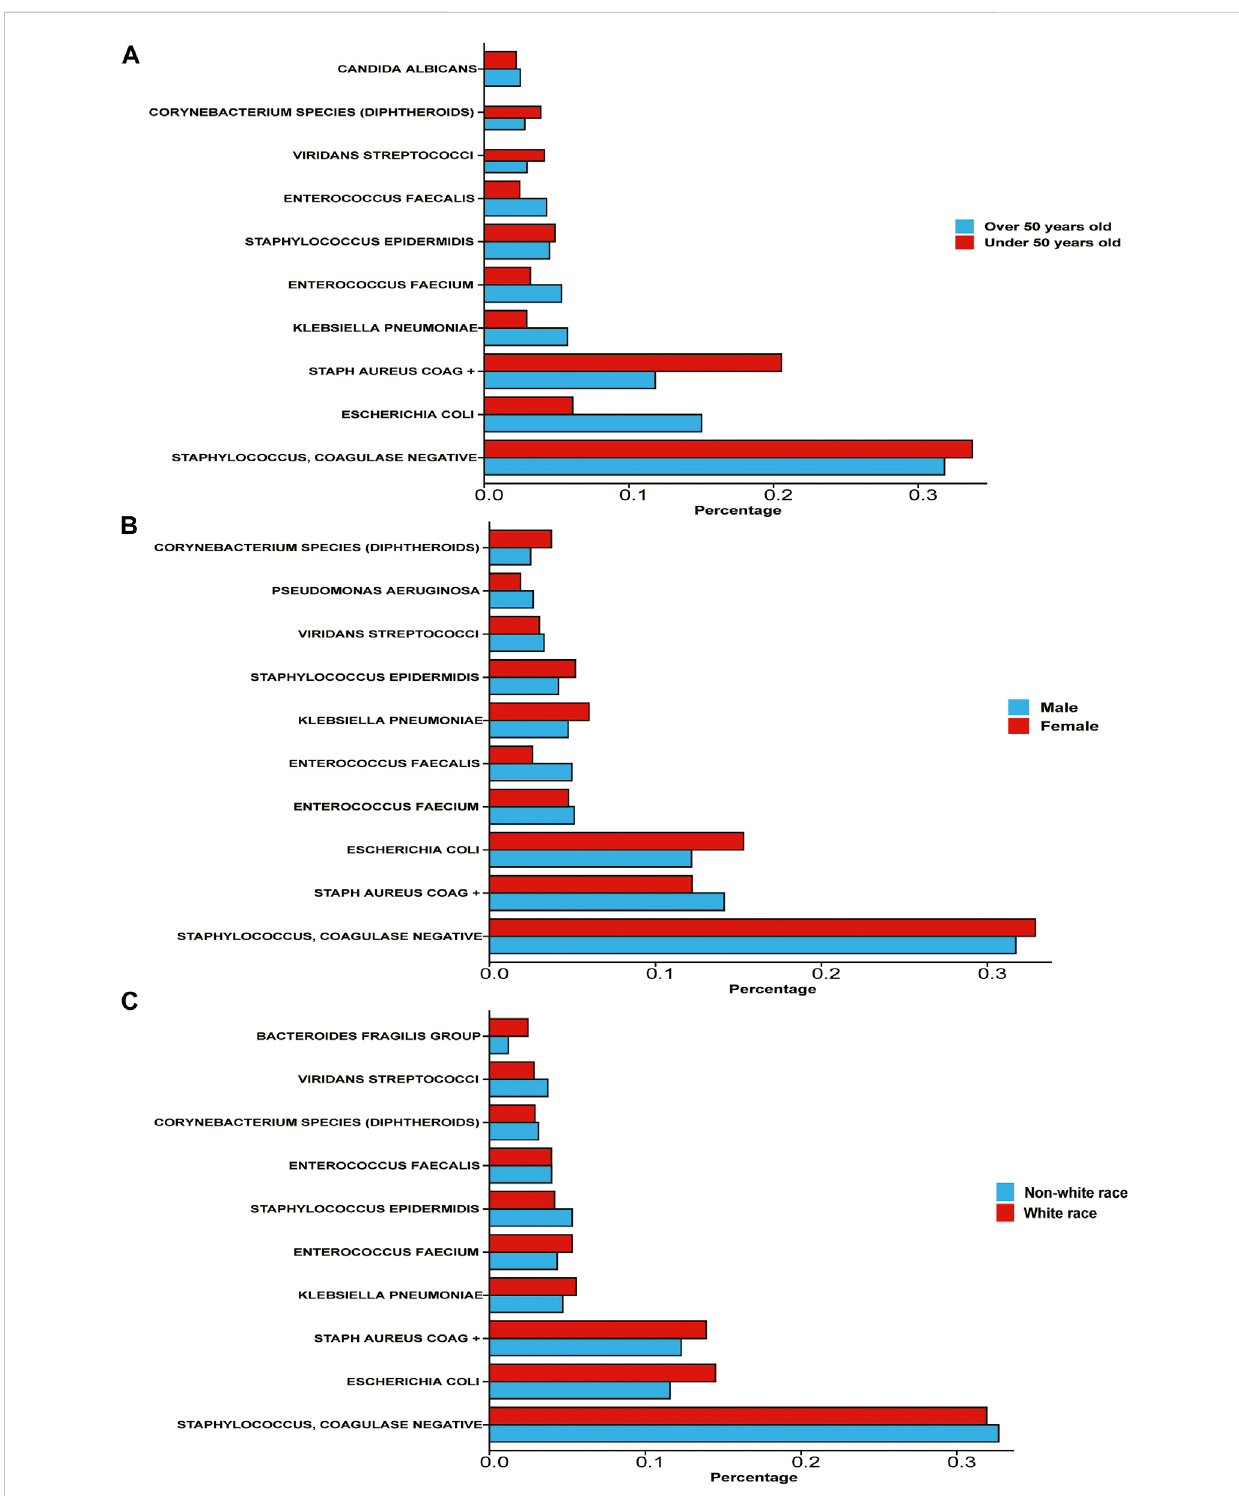
FIGURE 1 Percentage of various bacterial infections among different subgroups of population (A) the population is divided into two subgroups: over 50 years old and under 50 years old According to the age of patients. (B) The population is divided into two subgroups according to patient gender. (C) The population is divided into white race and non-white race according to patient